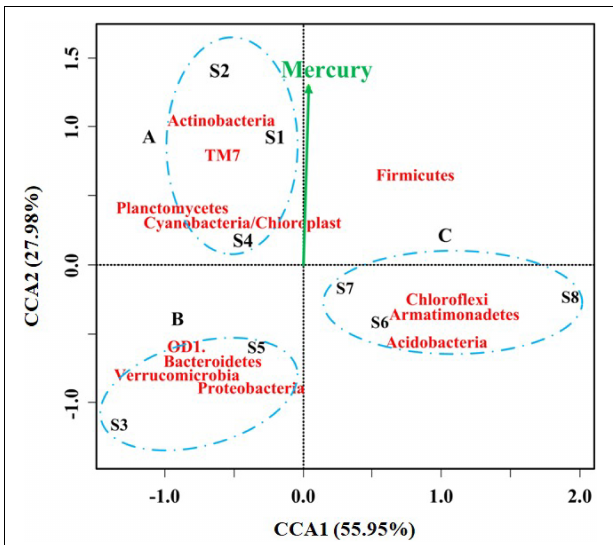
FIGURE 4 | Correspondence Canonical Analysis (CCA) of the eight sediment samples at phylum level (55.95% of the scores variation could be explained by CCA1 and 27.98% by CCA2). Only the concentration of mercury was significantly correlated with the microbial community variation ( p = 0.043, r 2 = 0.748). The samples could be grouped into three clusters, cluster A included S1, S2 and S4, cluster B included S3 and S5, and cluster C included S6, S7, and